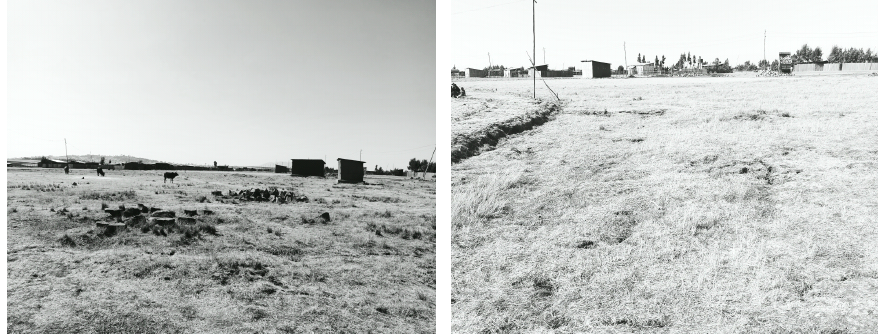
Figure 3. Partitioned farmland prepared for sale in Lega Tafo Lega Dadi town. (Source: Field observations, 30 December 2022).